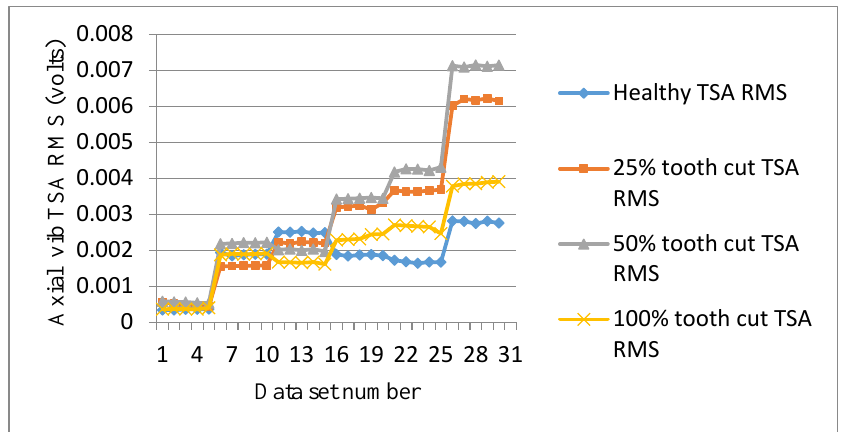
Figure 11. RMS of axial vibration TSA